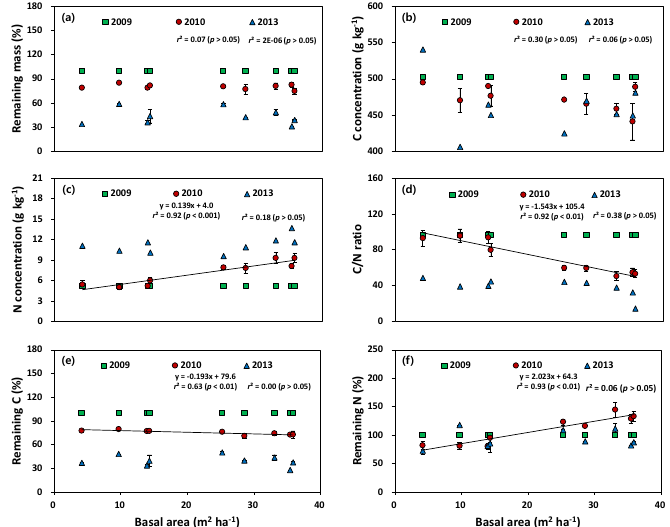
Figure 4. Relationships between basal area and decomposition of needle litter [( a ) remaining mass, ( b ) carbon and ( c ) nitrogen concentration, ( d ) C/N ratio, ( e ) remaining C and ( f ) N] in pine wilt disease disturbed stands ( n = 3). Vertical bars represent standard error.